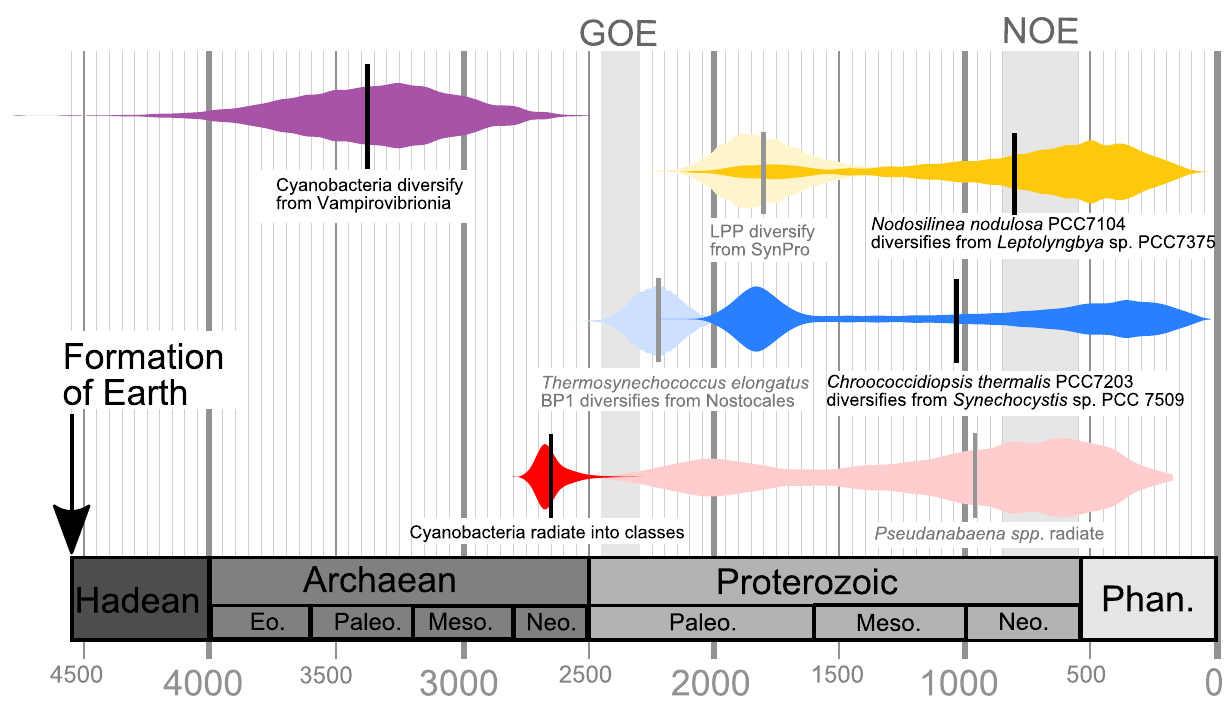
Fig. 4 Emergence of cyanobacteria (purple) and their CuZnSODs (red), NiSODs (orange), and Mn- and/or Fe-utilizing SODs (blue) inferred through geological time. Coloured bands represent the distribution of age posterior estimates (Table 2) for key nodes in a Bayesian molecular clock parameterized with uncorrelated Gamma Multipliers 49 and calibrated with the fi rst radiation of cyanobacteria between 2.32 and 2.7 Ga. Vertical black lines represent the mean in each instance. Dark-colored bands represent the earliest cyanobacteria predicted to have genes encoding the relevant SOD isoform based on a hypothesis of vertical inheritance, whereas paler nodes require horizontal gene transfer or other patterns of reticulated evolution as described in the text. Phan Phanerozoic eon; Meso Mesoproterozoic era; Neo Neoproterozoic era; GOE Great Oxygenation Event, NOE Neoproterozoic Oxygenation